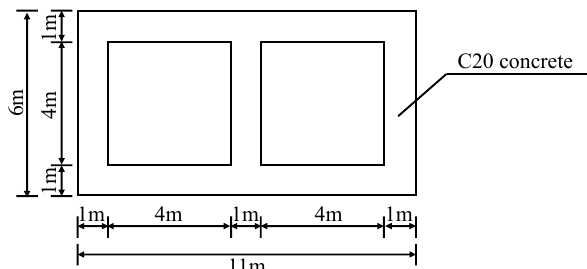
Figure 2. Culvert design size.